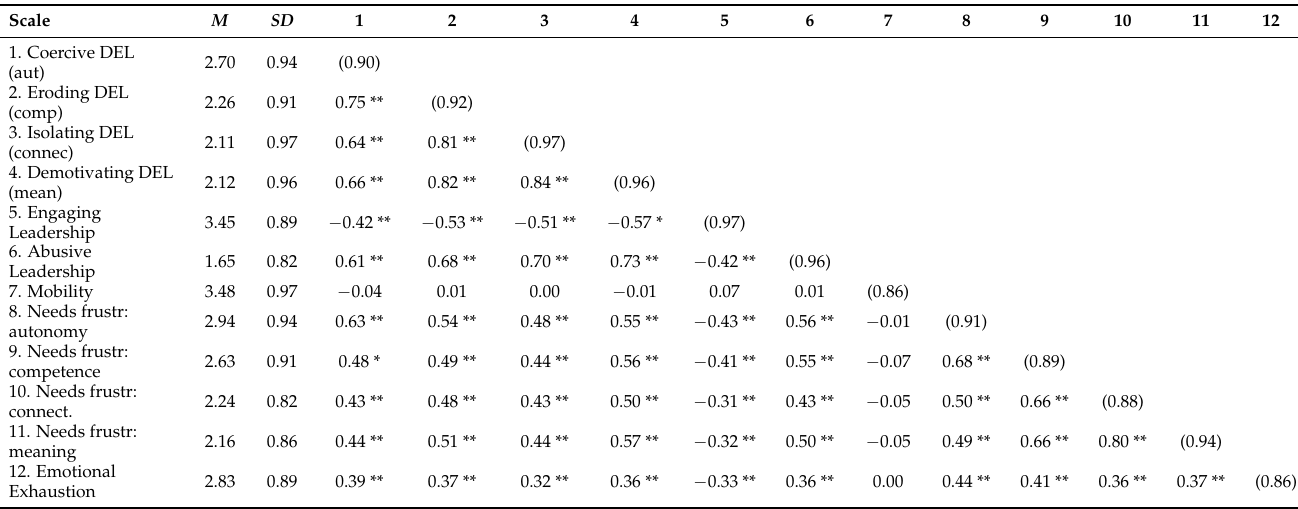
Table 3. Means (M), Standard Deviations (SD), Intercorrelations, and Reliabilities (in Parentheses) of the Study Variables ( N =